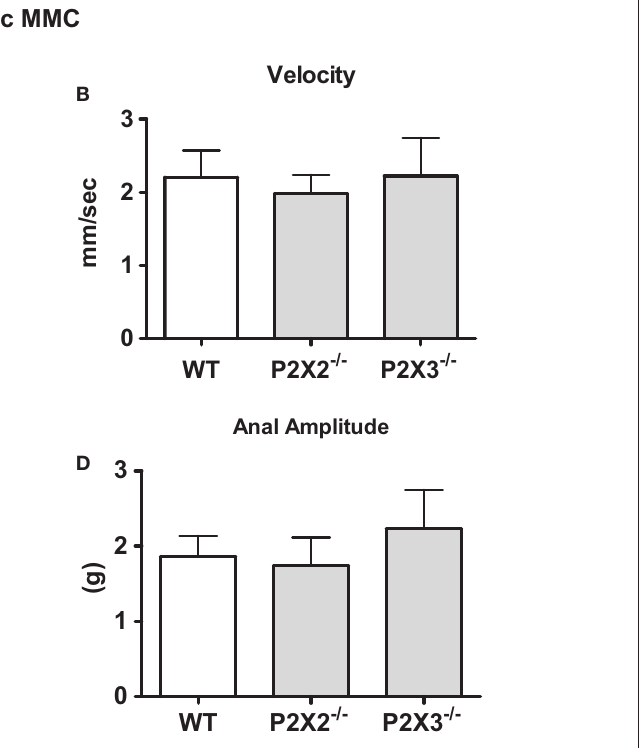
was not altered by P2X2 or P2X3 subunit KO mice. The amplitude of contractions at the oral end (C) or anal end (D) of colonic segments was not altered by P2X2 or P2X3 subunit KO ( P > 0.05). Data are mean ± SEM. Data analyzed by the Kruskal–Wallis and Dunn non-parametric multiple comparisons